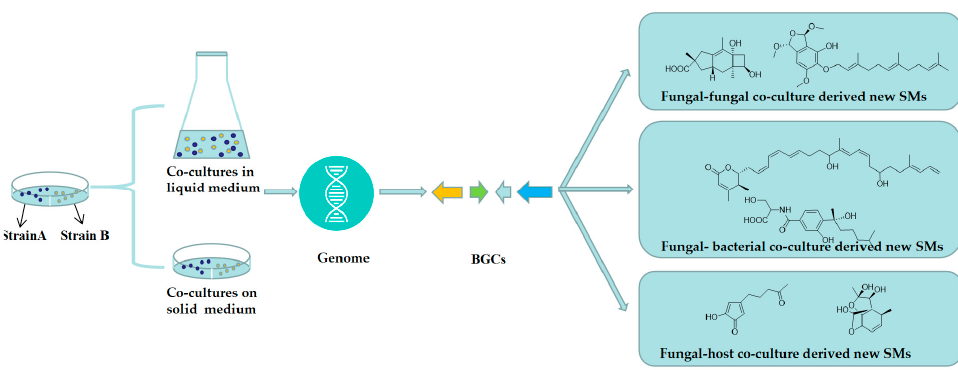
Figure 1. Flowchart for chemical study using fungal co-culture strategy.